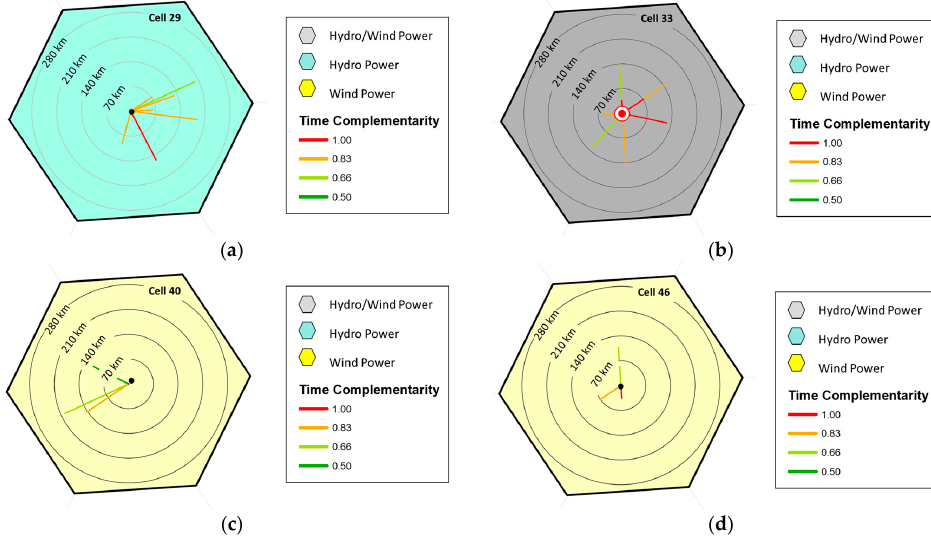
Figure 4. Complementarity roses for the cells ( a ) H-29; ( b ) W-33; ( c ) W-40; and, ( d ) W-46 (Figure 2).